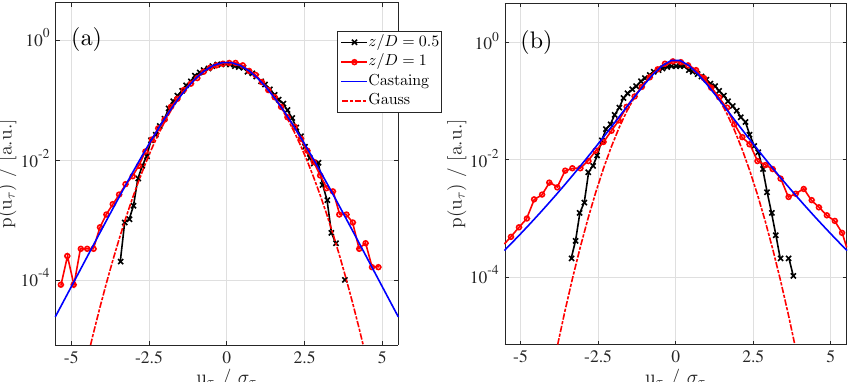
Figure 8. p ( u τ ) of the time series at two measurement positions ( y = 0 , z = D/ 2; y = 0 , z = D ), corresponding to the red marks in Fig. 7. (a) NTNU turbine, (b) ForWind turbine, both at γ = 0 ◦ . The timescales τ are related to the length scales of rotor diameters by Taylor’s hypothesis using Eq. (8). For z/D = 1 (red curve) the Castaing distribution is shown with λ 2 et al., 1990). A Gaussian fit is added to guide the eye.